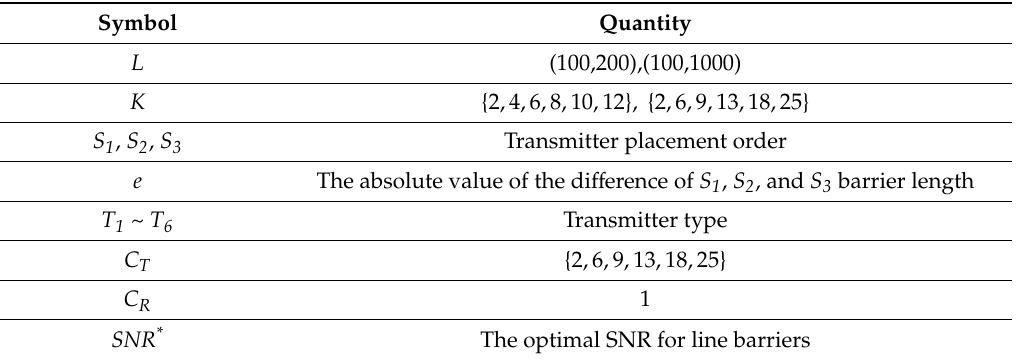
Table 2. Parameter